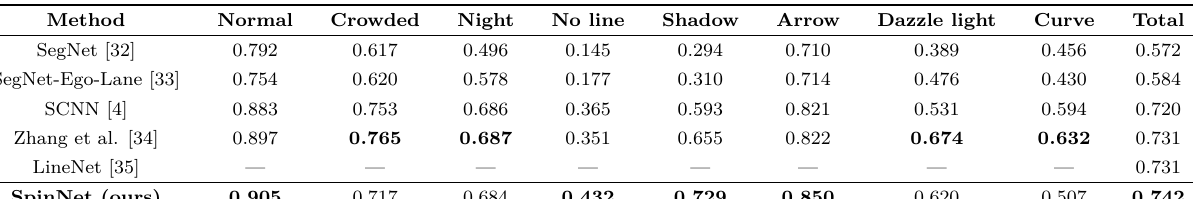
Table 4 Lane boundary results on CULane dataset (F1-measure). The columns from “Normal” to “Curve” show the effectiveness comparison in some particular scenario. The column “Total” shows the overall performance in the whole test set of CULane dataset, indicating that our SpinNet achieves new state-of-the-art result